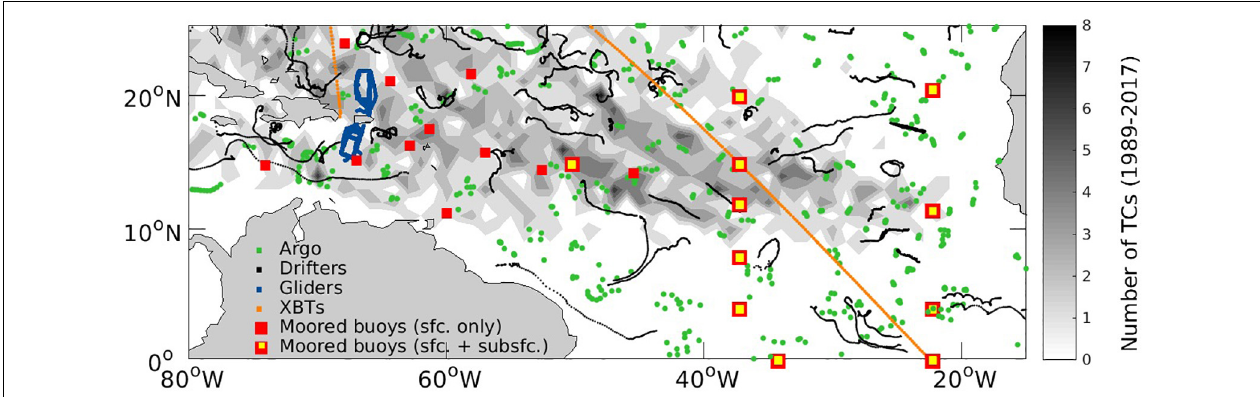
FIGURE 11 | Key components of the sustained ocean observing system for extreme weather. Shading shows the number of tropical cyclones that passed through each 1 ◦ × 1 ◦ box during 1989–2017, based on “best track” data. Black lines show the trajectories of all surface drifters during August 2018. Green dots show all Argo profiles made during August 2018. Orange lines indicate XBT lines, which are repeated approximately every 3 months, and blue lines represent ocean glider tracks during 2014–2018. Red squares indicate moored buoys with surface measurements, and yellow squares show moorings that additionally measure subsurface temperature, salinity, and/or